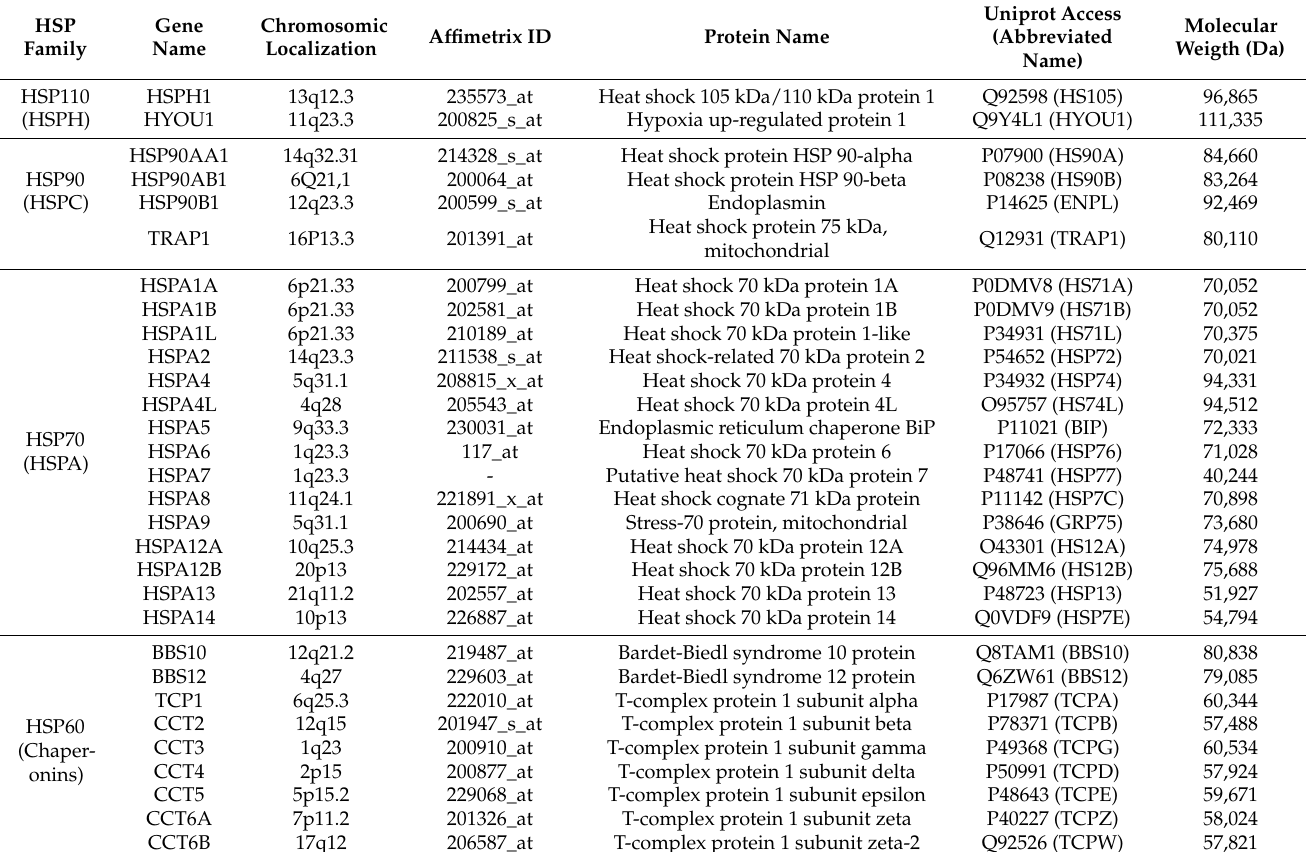
Table 1. List of 95 HSP family members classified into 6 sub-families according to their molecular weight (HSP110, HSP90, HSP70, HSP60, HSP40 and HSP20). For each HSP, the Gene name, Chromosomic localization, Affimetrix ID probe, Protein name, Uniprot database access number, Abbreviated protein name and Theoretical molecular weight, are reported. HSP